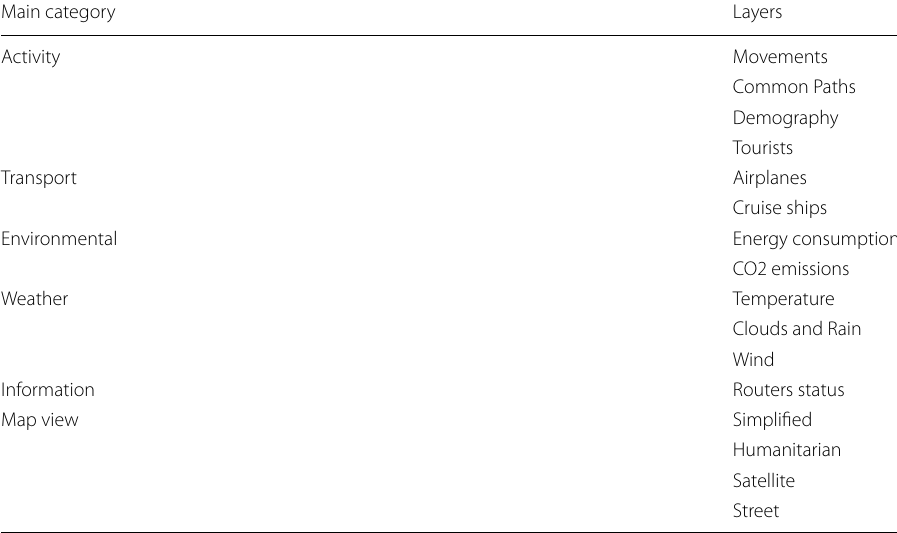
Table 1 The main categories and layers provided in ViTFlow Main